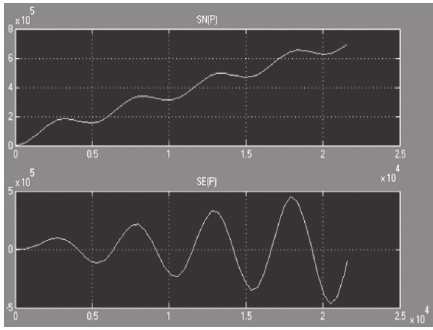
Fig. 8. Graphs of errors on both channels traversed the path of inertial systems when between the channels there is only one cross-link with transmission factor KprV (knpv = 0.001)